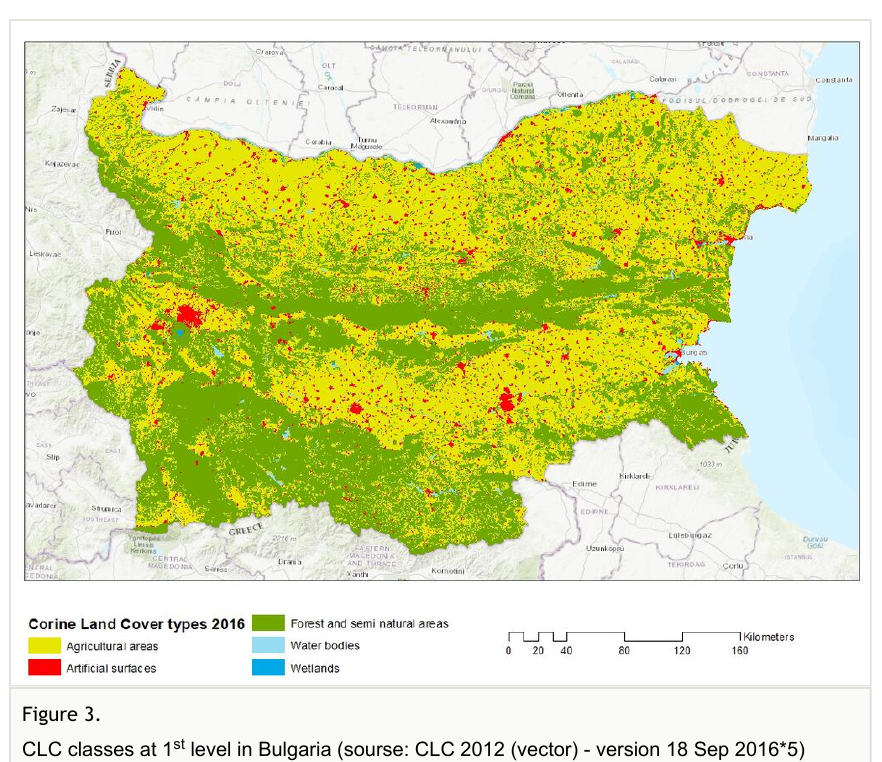
The ESTIMAP recreation model needs geospatial data, which are used in various GIS and tabular operations for land features identification. Different ES scores need to be assigned to the land features according to their capacity to provide the service. The ES scores given to each land feature are based on expert assessment or literature review (Zulian et al. (2013). GIS maps are used to represent the final value which is based on zonal statistics for the land features and the ES scores received. The data used for this study are obtained from open data sources. All the data and its sources are presented in Table 1. Most of the data sources are the same as in the ESTIMAP: ES mapping at a European scale (Zulian et al. 2014, Zulian et al. 2013). Most of the data used in our research are geospatial, only the data for bathing water quality are tabular, but it is processed and transformed into a GIS point layer. All the geospatial data we use are in vector format, except several intermediate raster layers obtained during the data